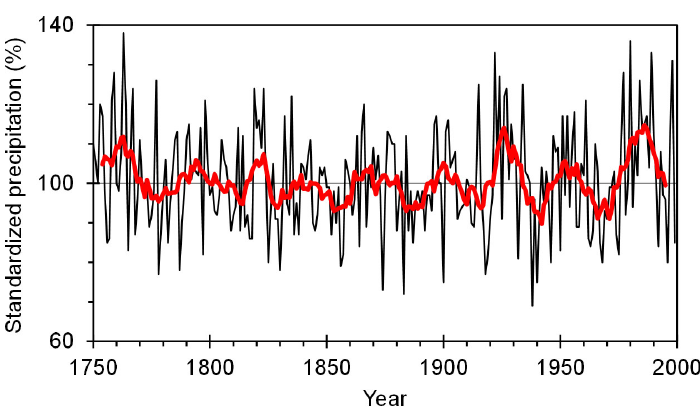
Fig. 7. Reconstruction of annual sums of relative precipitation amounts together with 9-year running averages in Estonia (according to data presented in table 4.2.3, Tarand et al.